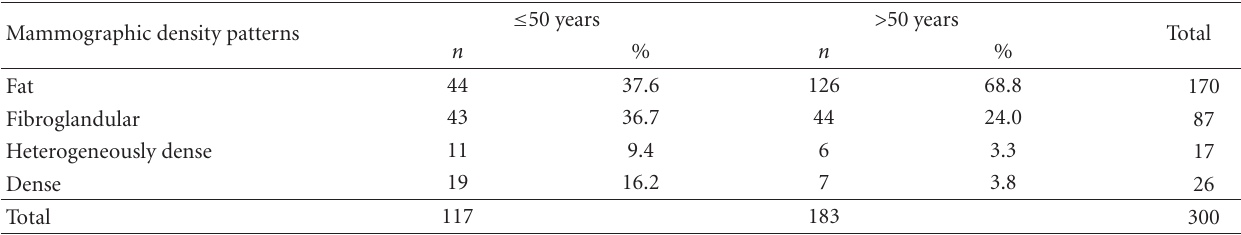
Table 4: Breast density in women younger and older than 50